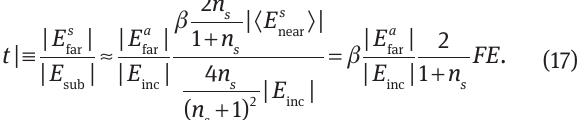
Figure 11: Schematic for far-field measurement of THz field passing through a gap in metal.